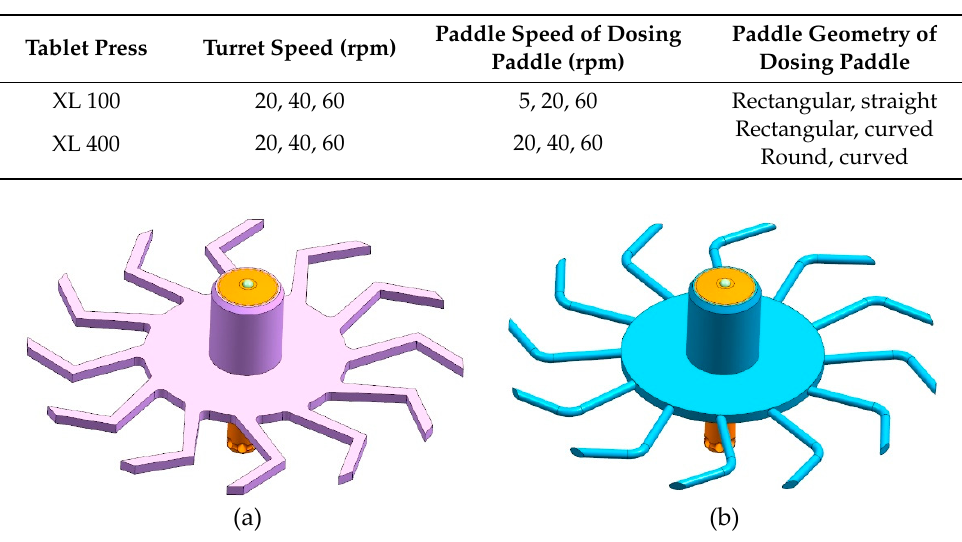
Figure 2. Dosing paddle geometries of XL 400: ( a ) rectangular, curved bars; ( b ) round, curved bars.